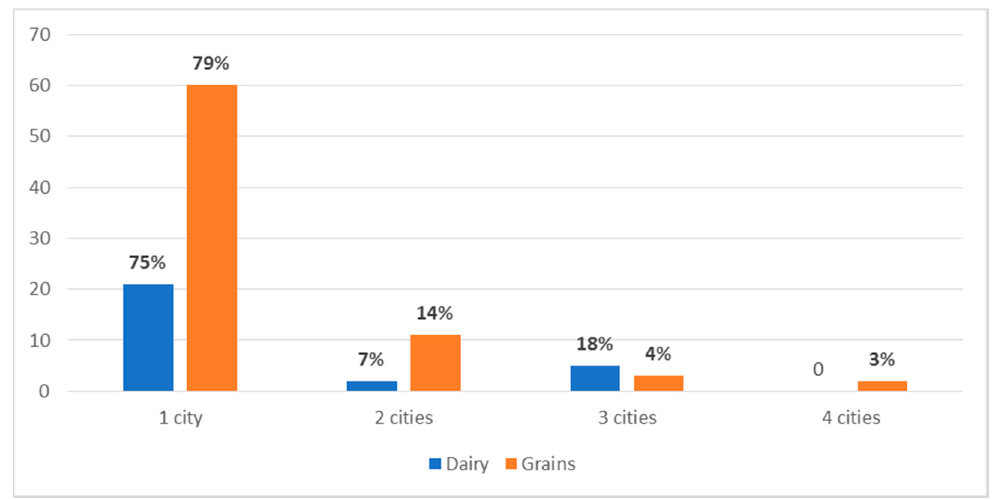
Figure 2. Number of Malian manufacturing firms distributing processed grain and dairy products in one or more cities. (Source: Inventory dataset (2016), as computed by the